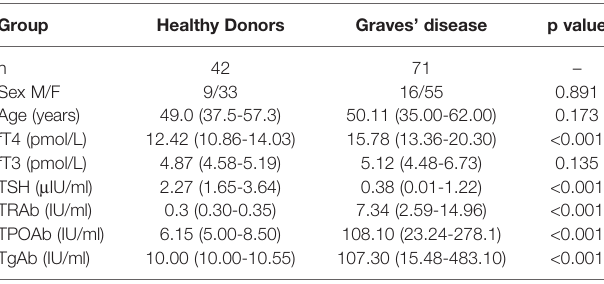
TABLE 1 | Demographic and clinical characteristics of healthy donors and Graves ’ disease